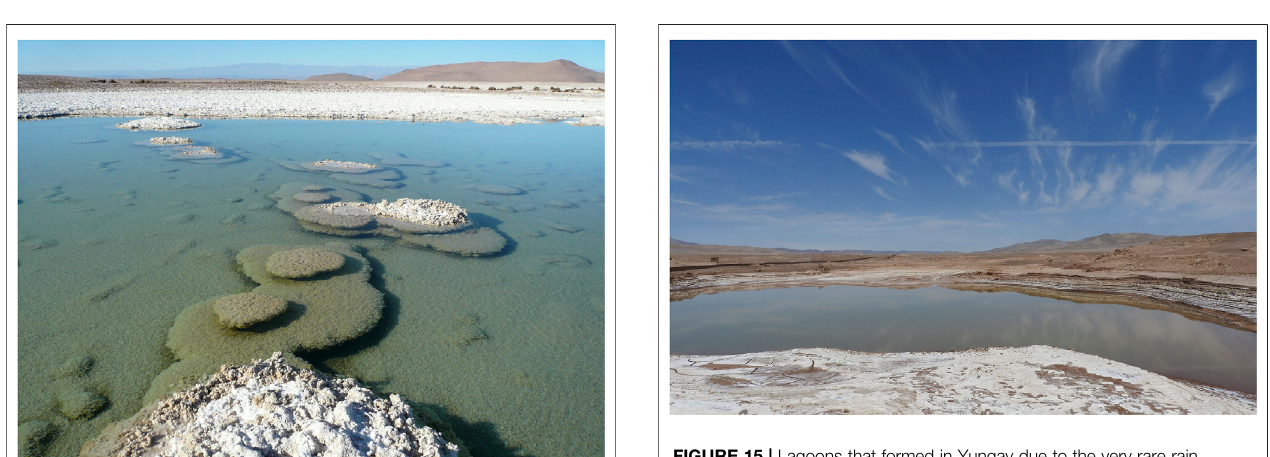
FIGURE 15 | Lagoons that formed in Yungay due to the very rare rain event that took place in